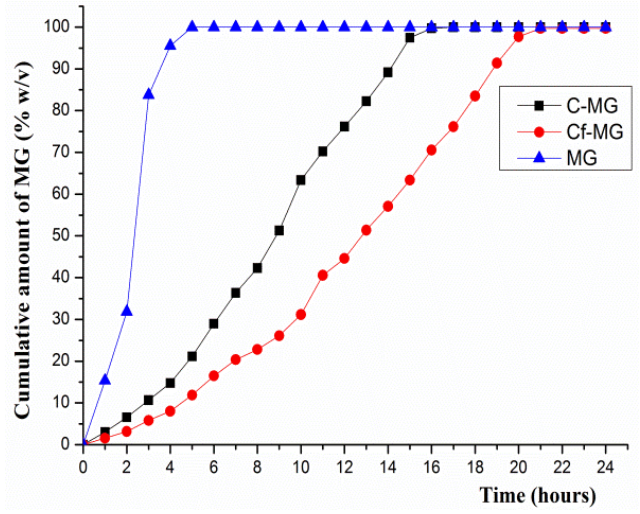
Figure 4. In vitro dissolution release of MG form mesoporous silica.